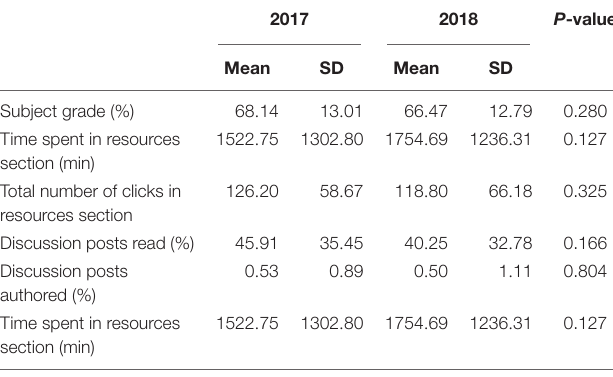
TABLE 3 | Student commitment data for 2017 ( N = 134) and 2018 ( N =